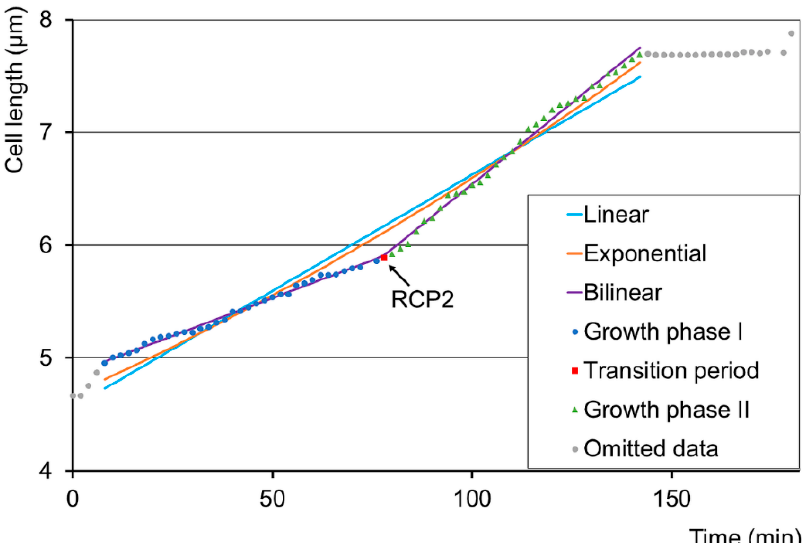
Figure 1. Illustrative length growth profile of an individual wee1-50 mutant fission yeast cell with an adequate bilinear pattern. Measured cell length is shown as a function of time, with the different parts of the cell cycle (growth phase I-II, transition period and constant length period) indicated. All the three fitted models (linear, exponential and bilinear) are